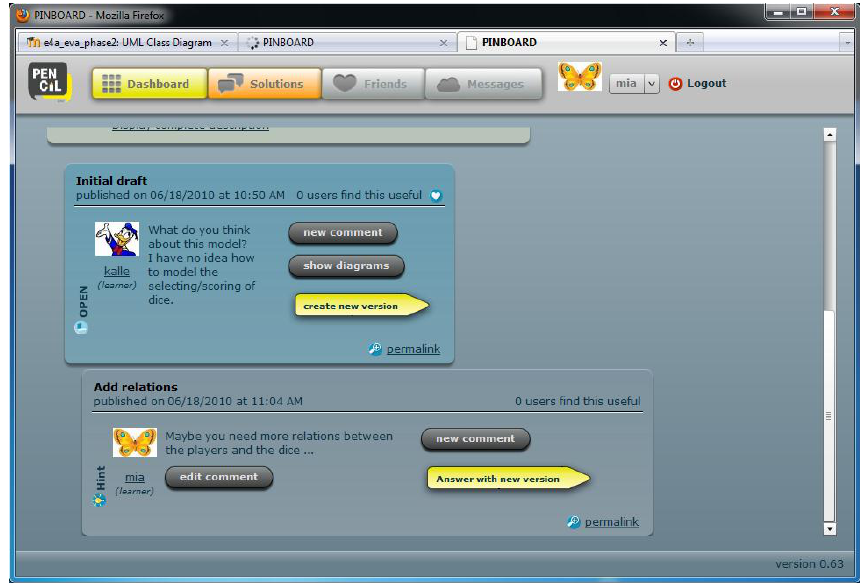
Figure 3. Example discussion